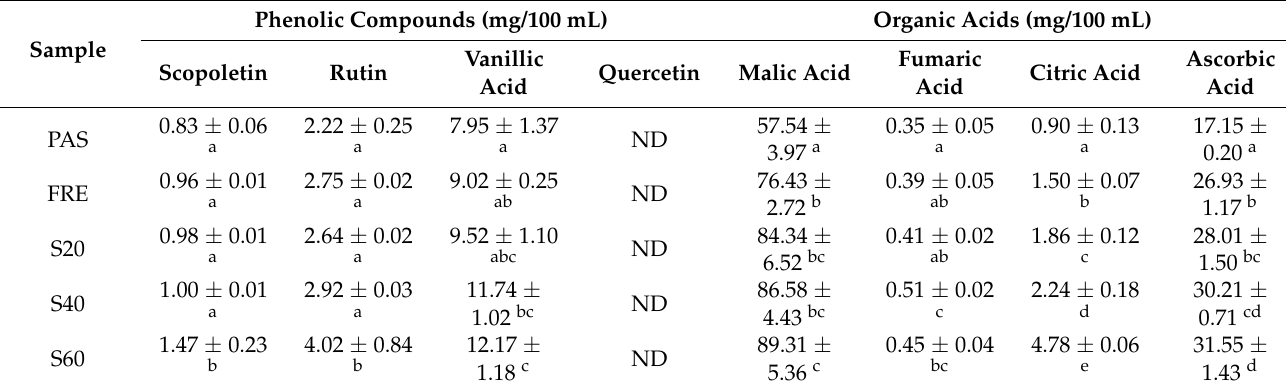
Table 3. Phenolic and organic acid